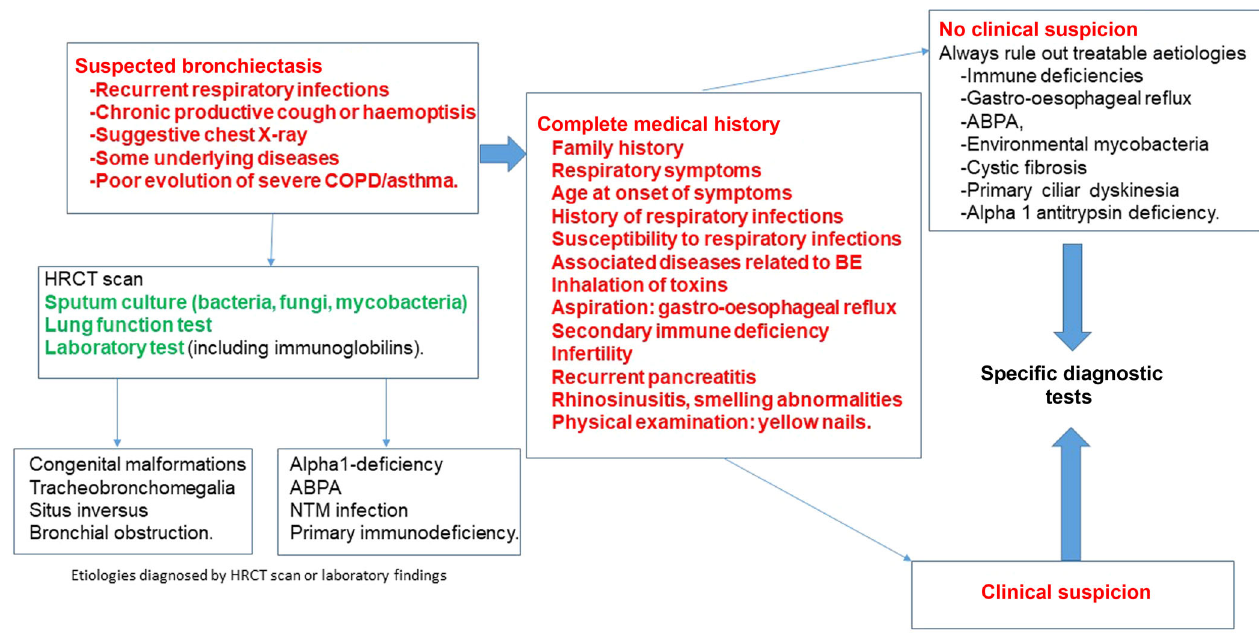
Fig. 2 From suspected bronchiectasis to speci fi c diagnosis test. In red: To be performed in Primary Care. In green: To be performed in Primary Care (if available). In black: To be performed in secondary/specialized centre. HRCT high-resolution computed tomography, COPD